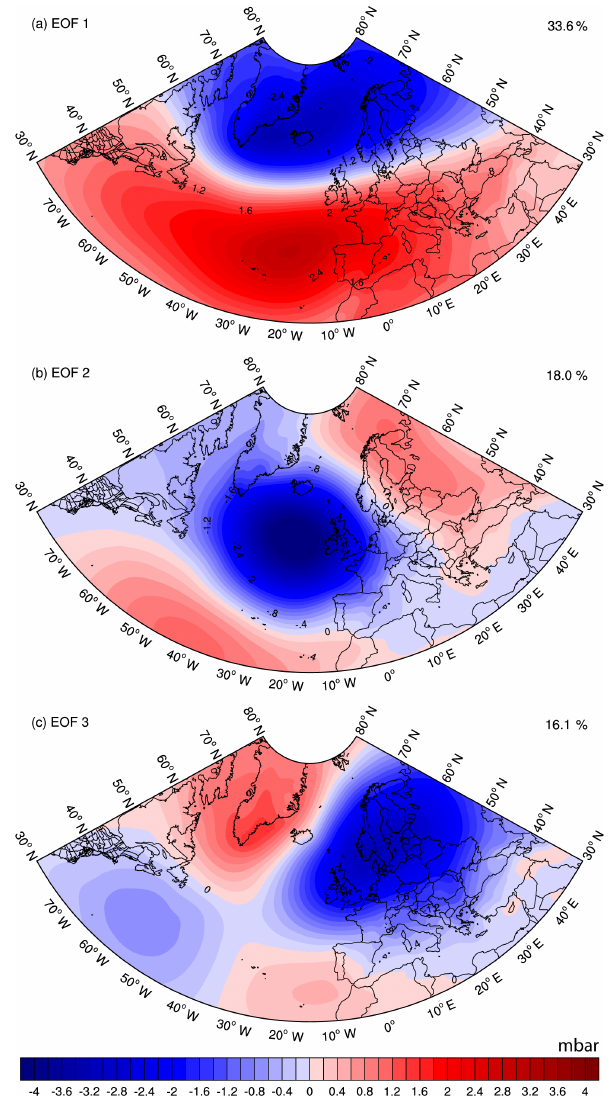
Figure 2. The first three EOF modes of deseasoned and detrended ERA Interim MSLP (1991–2015) multiplied by the standard devia- tion of the corresponding principle components. The number in the top right corner of each panel indicates the percentage of variance